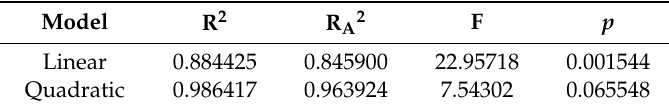
Table 3. Analysis of variance (ANOVA) of linear and quadratic models for viscosity with a 95% confidence interval.